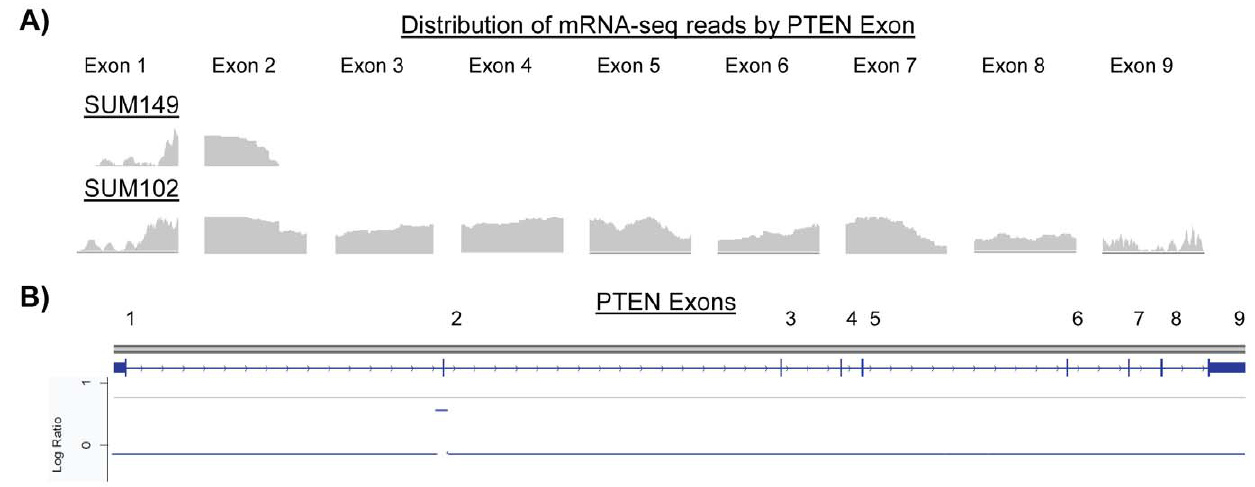
Figure 4. Micro-amplification in PTEN in the SUM149 cell line disrupts exon expression. A) The distribution of mRNA-seq reads by exon is shown for the SUM149 and SUM102 cell lines. B) For reference, the genomic space of the PTEN gene is shown, along with the copy number status by SWITCHdna across the PTEN gene in SUM149. doi:10.1371/journal.pone.0051719.g004 PLOS ONE |